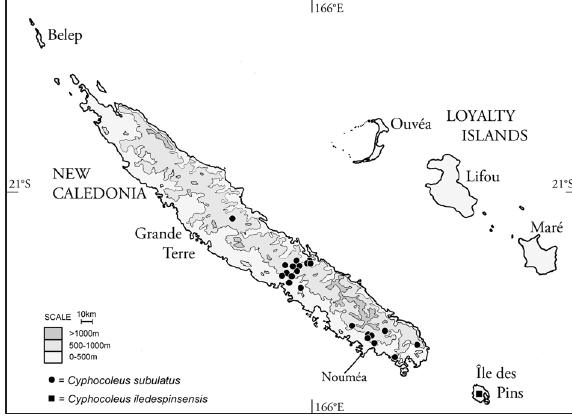
Figure 165. Distribution map of Cyphocoleus subulatus and C. iledespinsensis